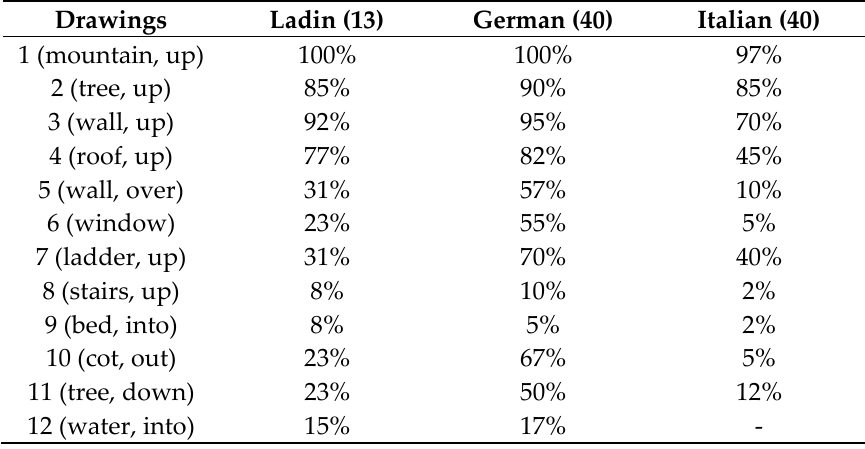
Table 10. Percentage of learners using climb in each drawing.